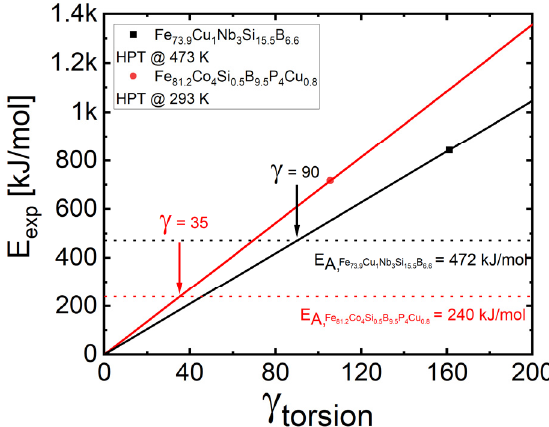
Figure 13. Expended energy E exp for alloys A (black) and B (red), during HPT, plotted vs. the HPT strain γ torsion with the critical levels of respective activation enthalpies E A , for the first stage of crystallization indicated. For alloy B, crossing occurs at a significantly smaller HPT strain than for alloy A.